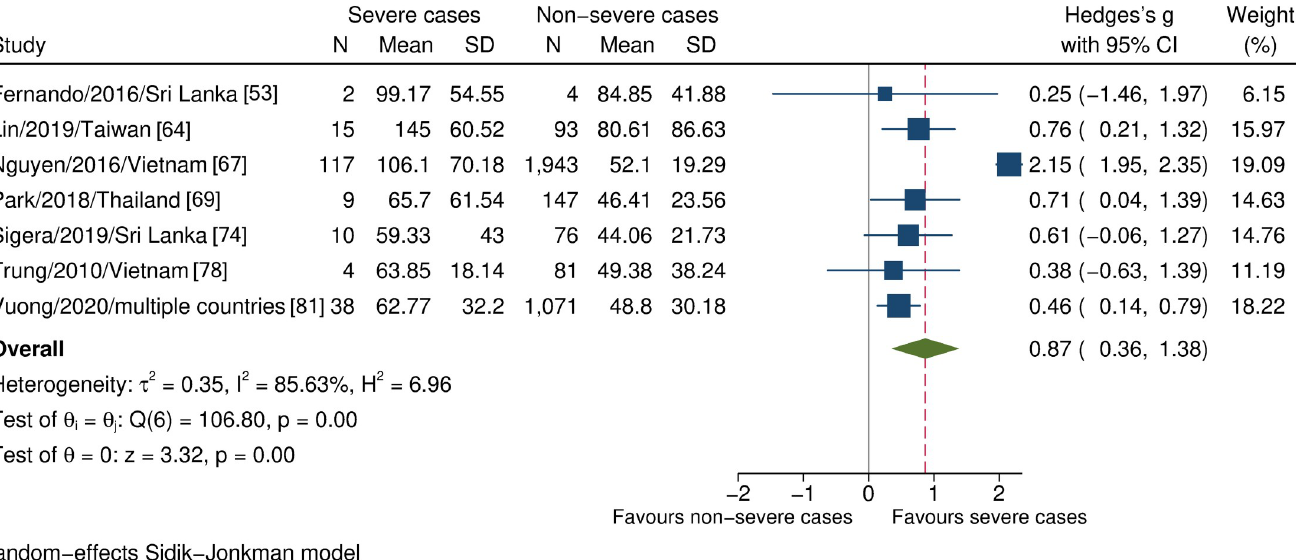
Fig 3. Forest plot showing the relationship between AST levels and severe dengue. One study was an outlier [67]; the estimated effects remained unaltered after the sensitivity analysis. The red dashed line represented the overall effect size.